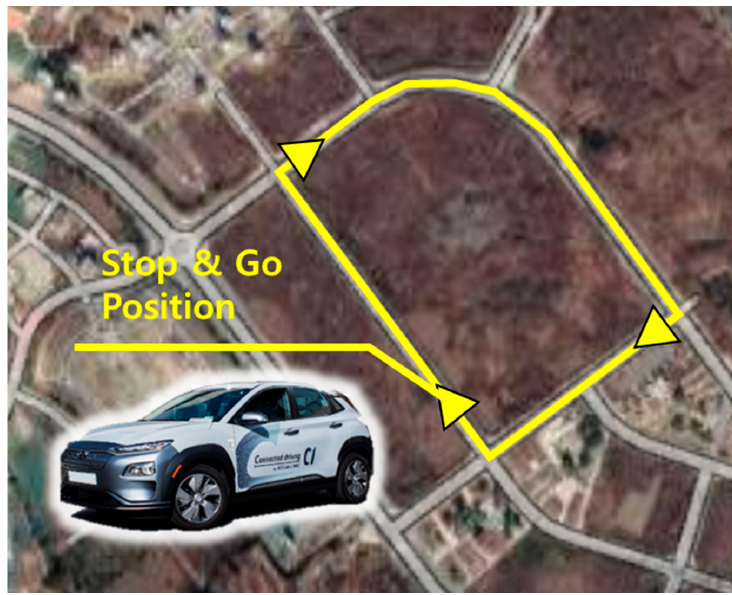
Figure 4. Driving scenario for the free-driving